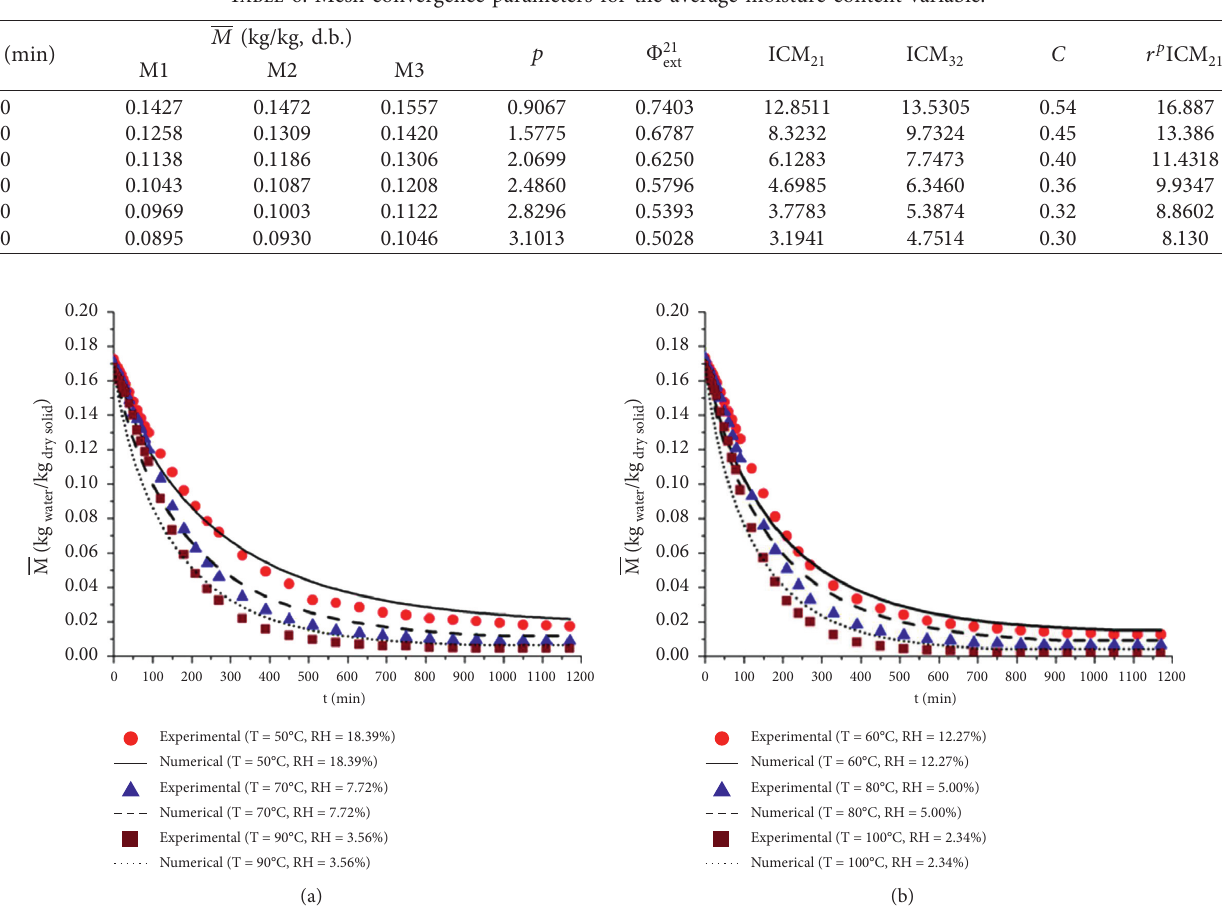
Figure 7: Drying kinetics of the industrial clay brick at different drying-air temperatures. (a) T � 50 ° C, 60 ° C, and 70 ° C. (b) T � 80 ° C, 90 ° C, and 100 °